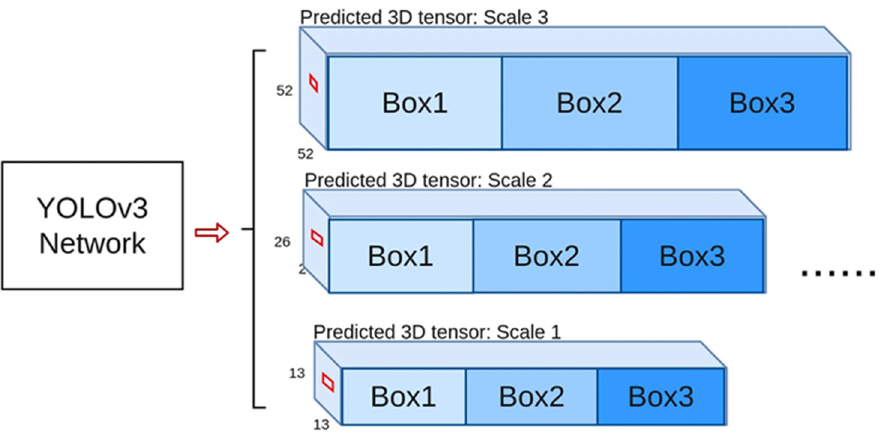
Figure 2. Yolov3 network structure